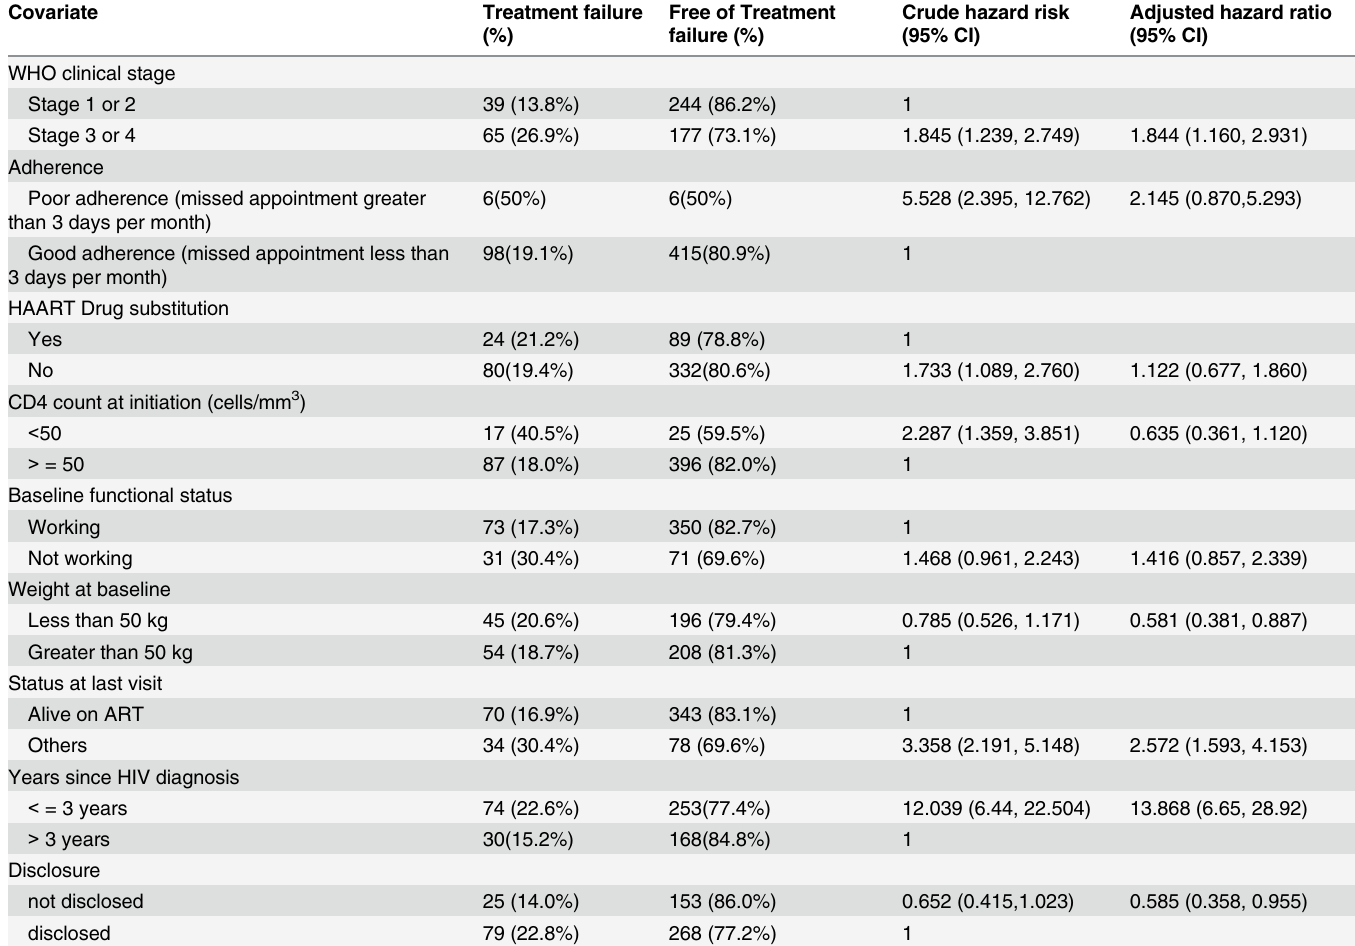
Table 6. Multivariate analysis showing predictors of ART treatment failure in private health facilities in Addis Ababa, 2009 –